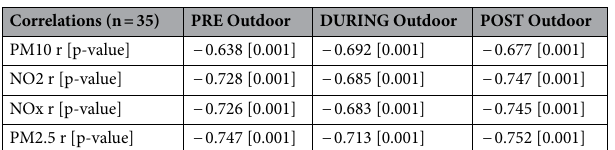
Table 3. Correlations outdoor index (subscale of the Living Environment index) and air pollutants.